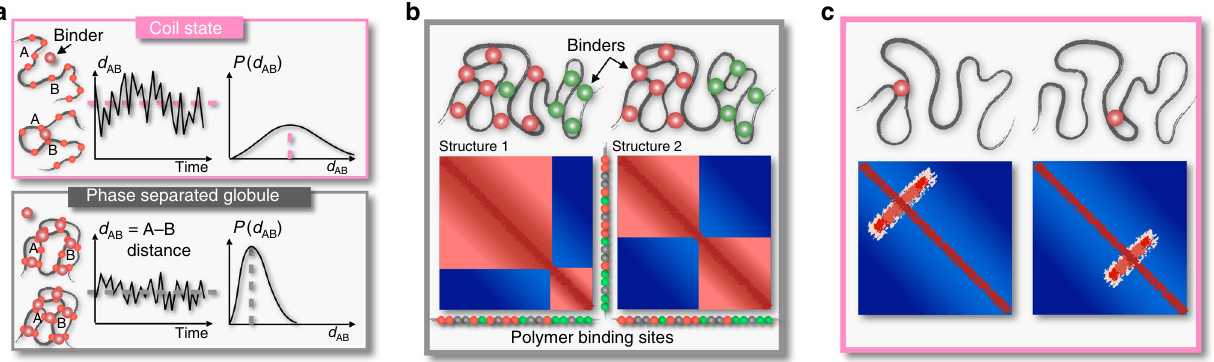
Fig. 5 Polymer phase separation explains chromatin structure variability across single-cells. a In the SBS model, the polymer folds in conformational classes associated to the thermodynamics phases of the system, e.g., the coil and the phase separated globule state, according to the abundance or af fi nity of binding molecules. The summary cartoon highlights that in the coil phase (top) chromatin contacts tend to be more fl eeting and average distances more open than in the phase separated globule state (bottom). Those thermodynamics states recapitulate single-cell architecture data. b Globule phase separation, for example, produces local compact environments, insulated one from the other, where speci fi c contacts are highly enhanced between regions enriched for cognate binding sites. The inherent thermodynamic degeneracy of conformations results in a variety of single-molecule 3D structures, re fl ected in the variability of the genomic position of TAD-like patterns, consistent with imaging data of loci in human HCT116 and IMR90 cells. c Cohesin depletion, as in HCT116 + Auxin cells, tends to reverse globule phase separation into the coil state resulting in much more variable contacts, abolishing patterns in bulk Hi-C